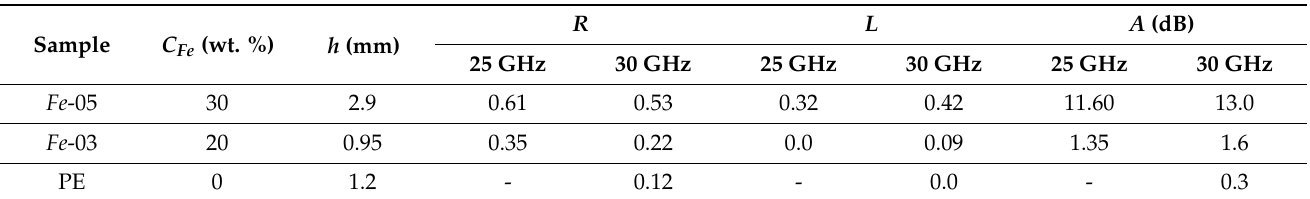
Table 12. The coefficients of attenuation A, reflection R, and loss L of samples based on iron-containing nanoparticles synthesized from Fe(HCOO) 3 .